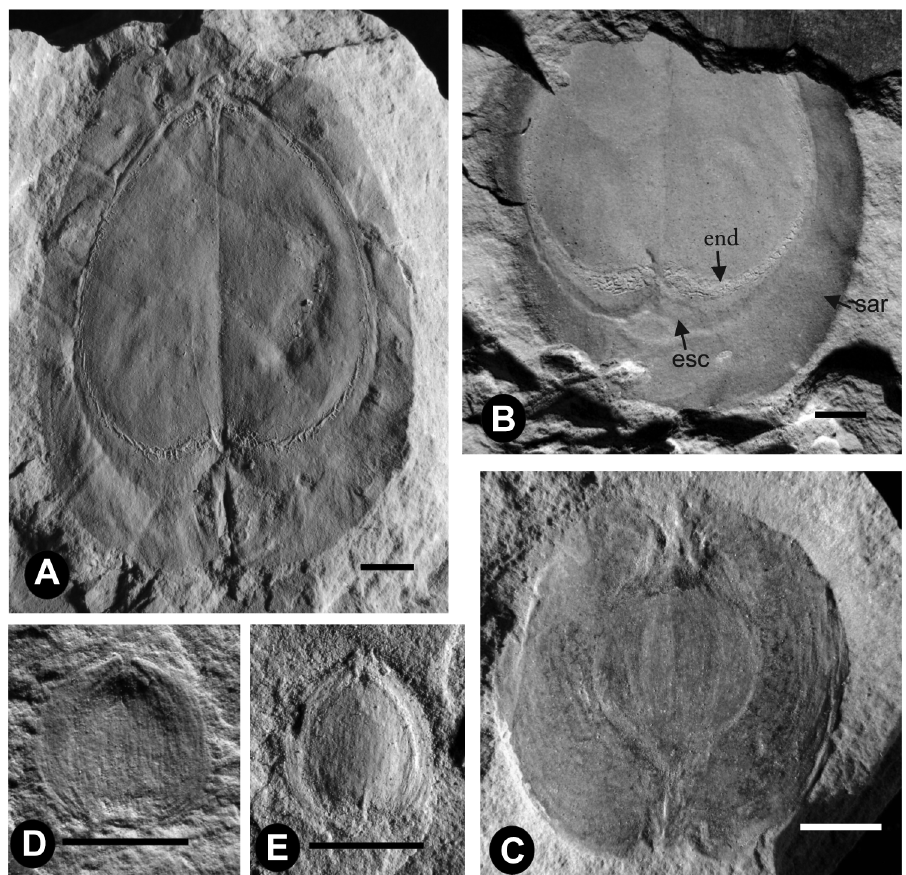
Figure 2: A , MP-Pb 3992, Samaropsis gigas , complete specimen; B , MP-Pb 3662, S. gigas, detail of the basal portion showing the three seed coats: endotesta, sclerotesta and sarcotesta; C , MP-Pb 2824a, Samaropsis Kurtzii , showing a well-developed membranaceous sarcotesta; D-E , MP-Pb 3941, MP-Pb 3946D, Samaropsis aff. S. millaniana , complete specimen. Abbreviations: end , endotesta; esc , sclerotesta; sar , sarcotesta. Scale bars: 5